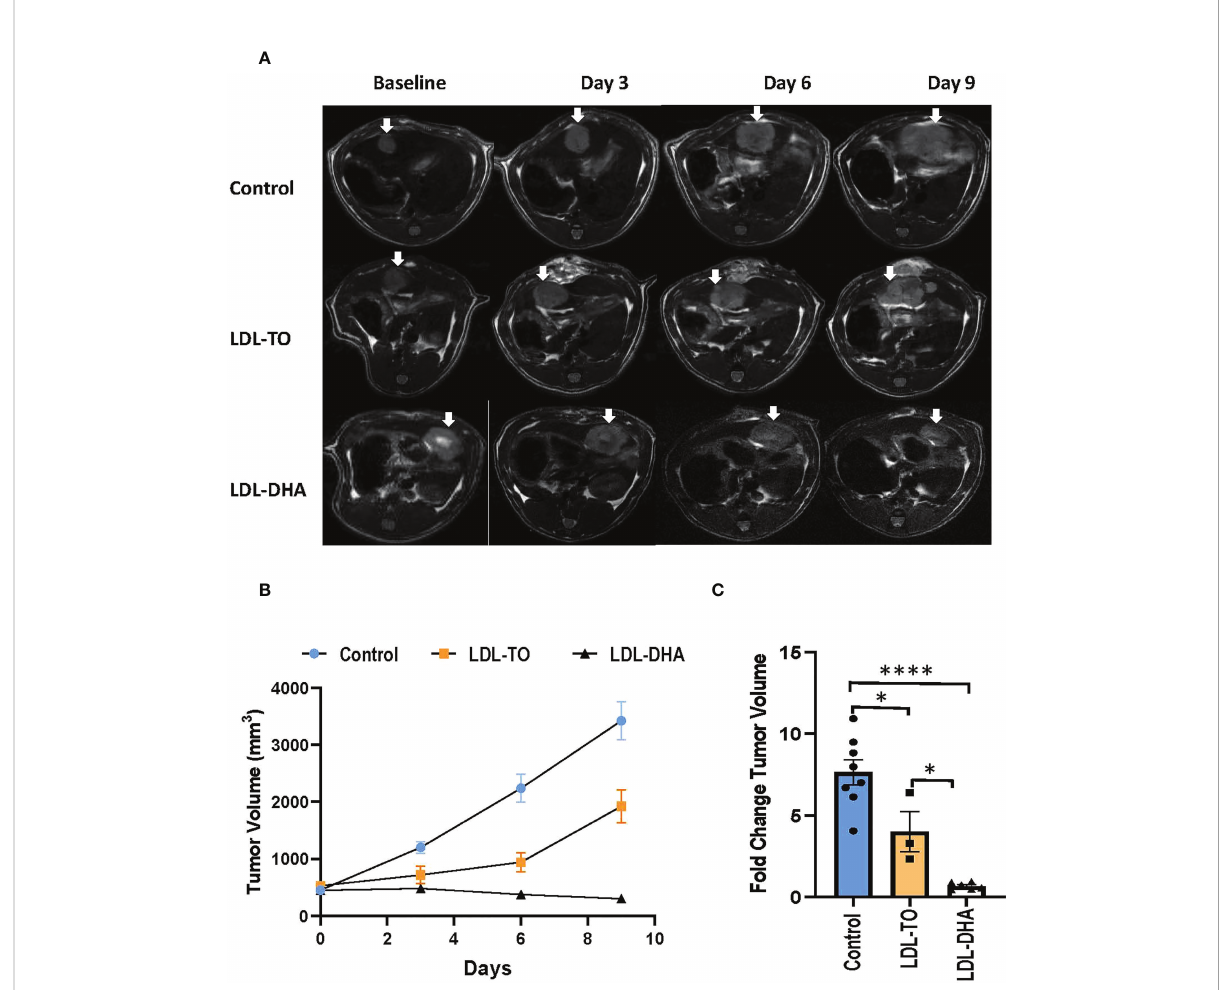
FIGURE 4 Tumor growth over course of repeated LDL nanoparticle treatments. (A) MRI assessment of tumor-bearing rats over the course of repeated LDL Nanoparticle treatments. Representative T2-weighted axial images of untreated controls, LDL-TO and LDL-DHA allocated rats at baseline, 3 days, 6 days and 9 days after LDL nanoparticle treatments. Tumor appear hyper-intense on T2-weighted images. White arrow indicates tumor. (B) N1S1 tumor volumetric assessment versus time over a course of repeated LDL nanoparticle treatments or no treatments. The average tumor volume for each group is presented in absolute volume (as calculated from MRI) and expressed as mean ± SEM. (C) Fold change in tumor volume at day 9 relative to corresponding baseline values. Signi fi cant differences between groups is expressed as mean ± SEM. *, P< 0.05; ****, P<